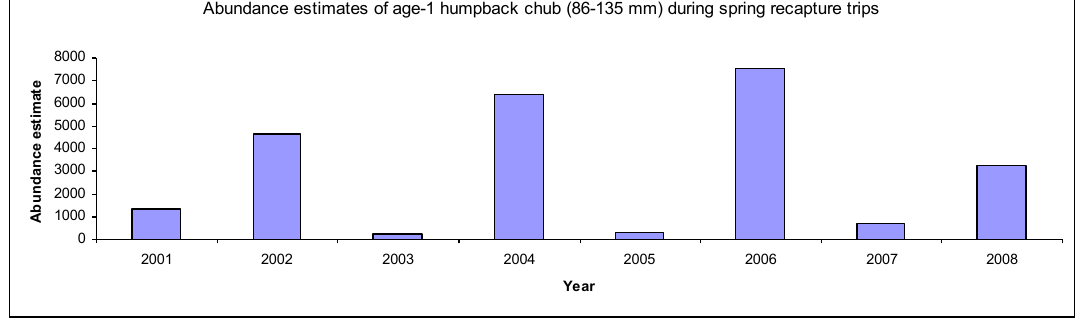
Figure A1.3. Abundances of age-1 humpback chub in the Little Colorado River (R. Van Haverbeke, U.S. Fish and Wildlife Service, and L. Coggins, USGS, pers. comm.,